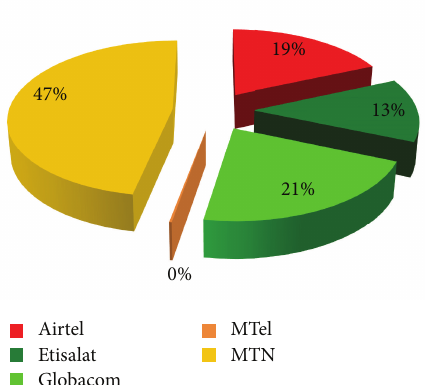
Figure 2: Market shares of GSM network operators as in June 2013 in Nigeria